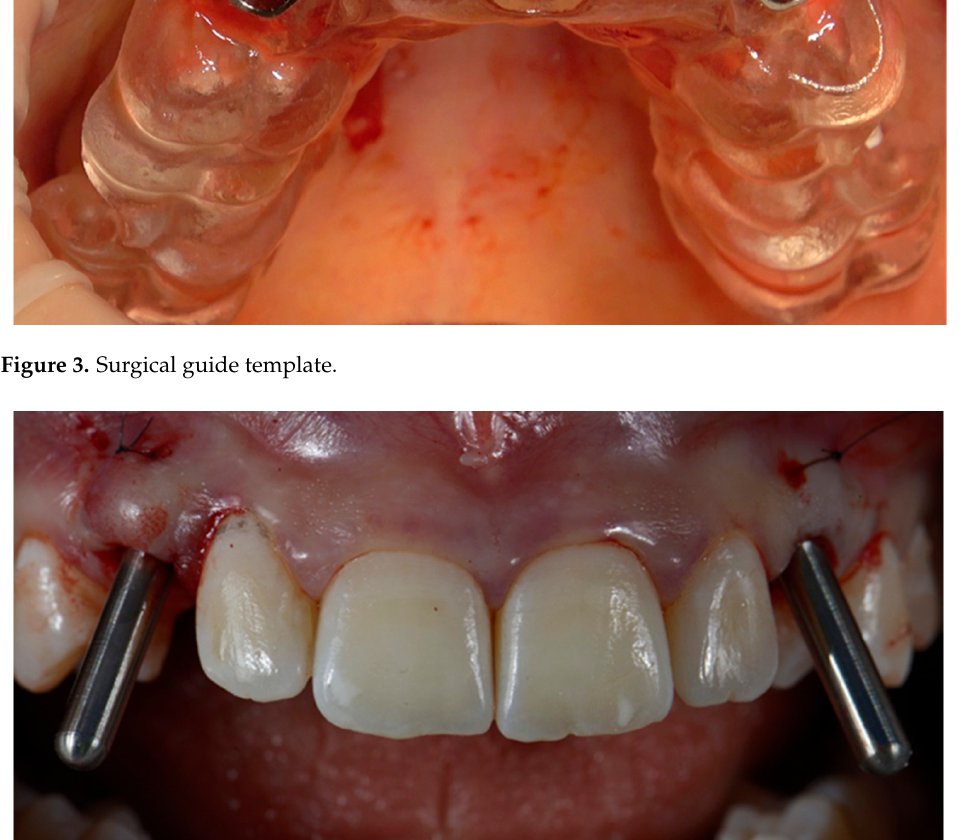
Figure 4. Implants insertion with positioning pins.